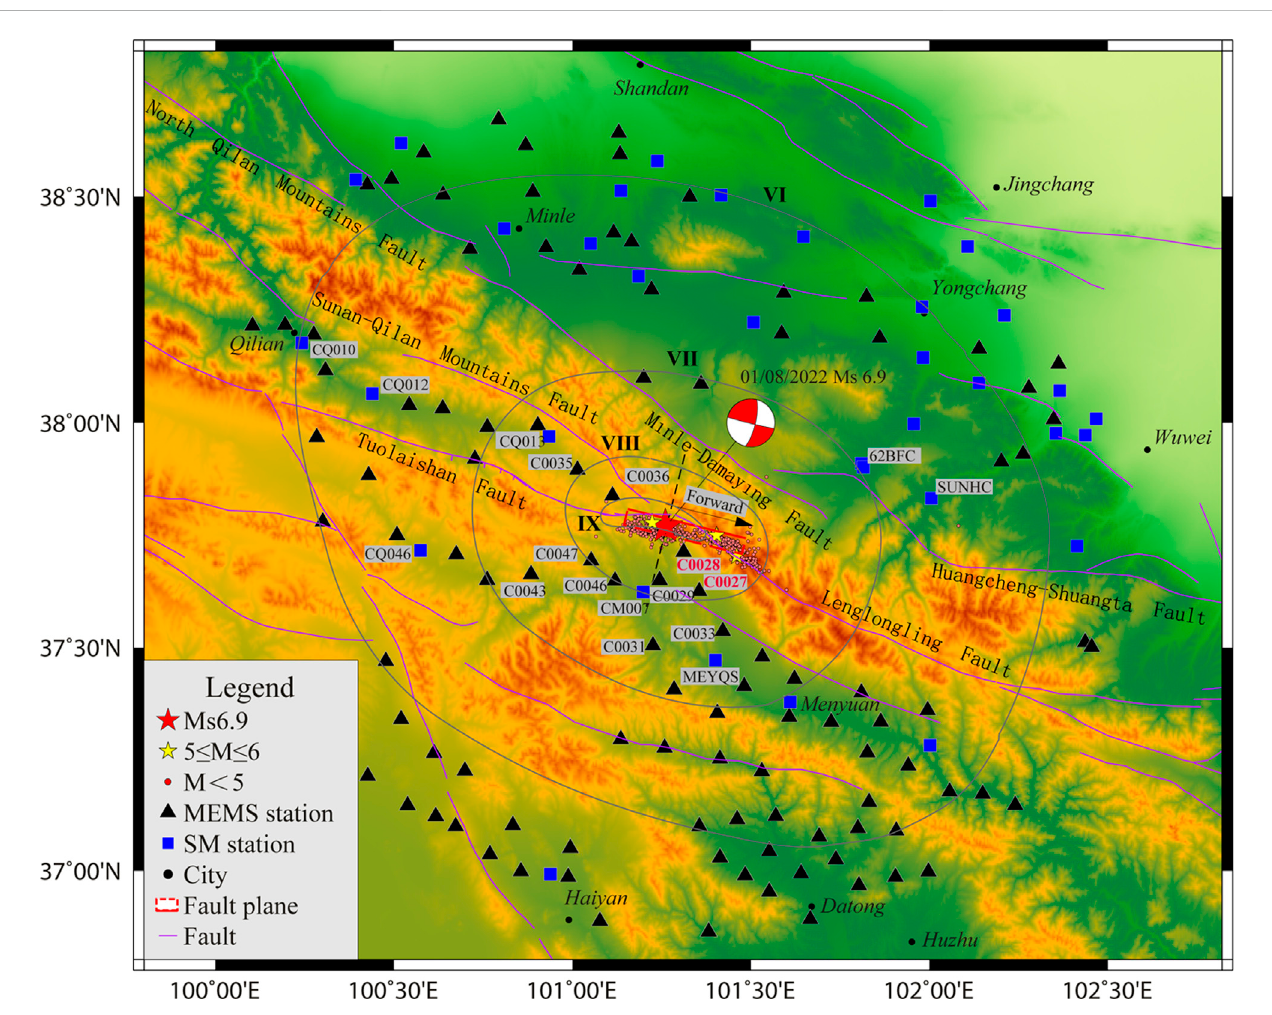
FIGURE 1 Location of the M S 6.9 Menyuan earthquake and distribution of strong motion and MEMS recording stations within 100 km of the causative fault. Observation stations (C0028 and C0027) from which standard pulse characteristic recordings were obtained are marked in red labels. The geometry of the fault plane with a rupture length of 30 km and a width of 18 km is from Liang et al. (2022) and was inverted from InSAR deformation data. The gray circles indicate the intensity map provided by the China Earthquake Administration (CEA) (2022). The gray circles from inside to outside denote intensities of IX, VIII, VII, and